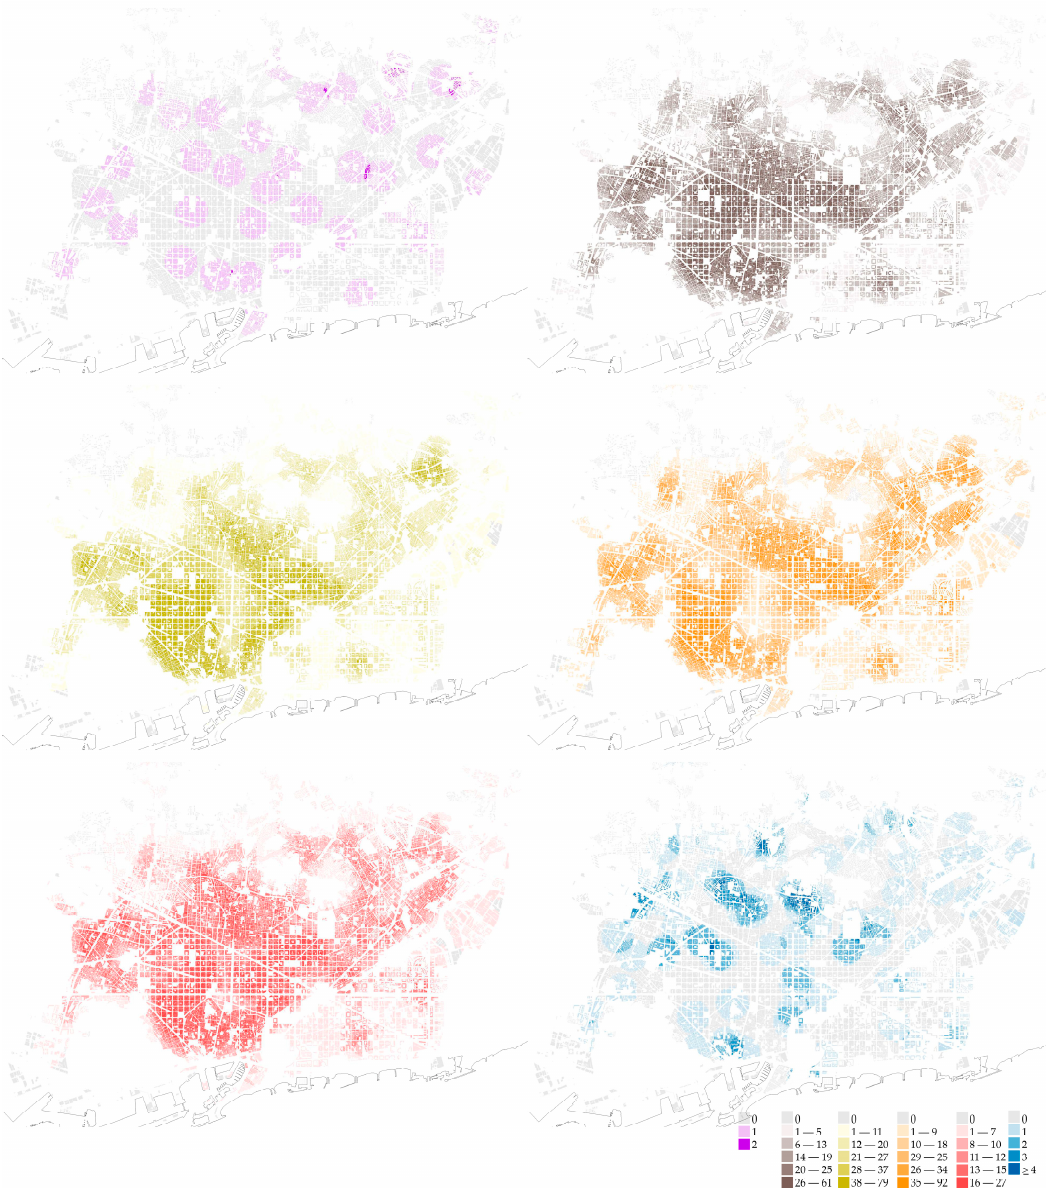
Figure 6. Urban fabric according to the proximity between essential services by category (from left to right and top to bottom: market halls, bakeries, supermarkets, grocery stores, pharmacies and healthcare facilities). Proximity between service units is represented by quintiles (the darker the hatch, the higher the concentration). Table A1 in the Appendix A of this document gives a detailed explanation with precise place names for knowledgeable readers of the